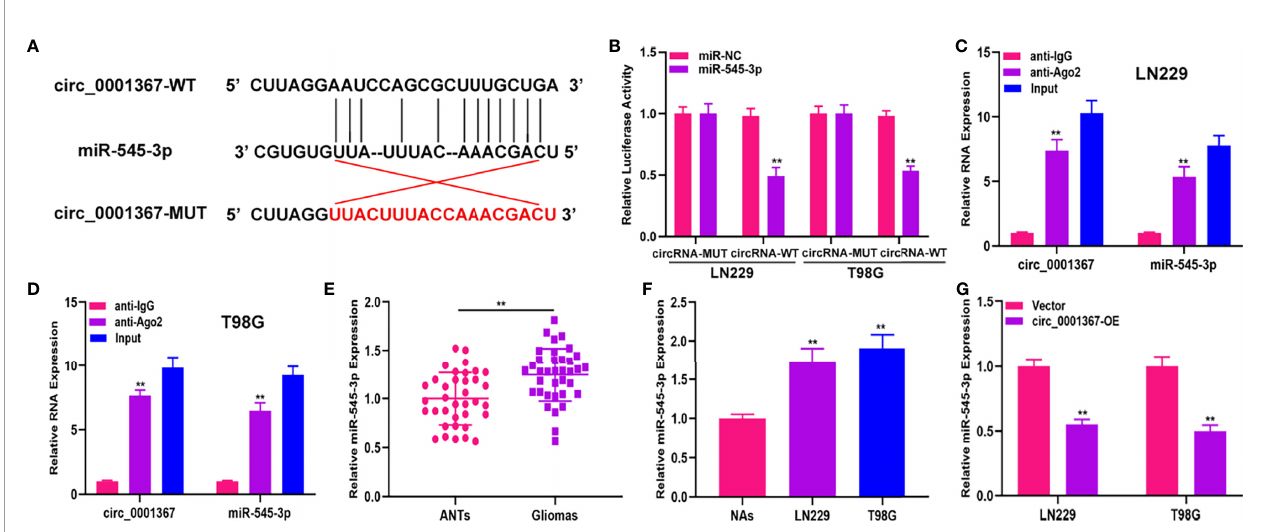
FIGURE 3 | Hsa_circ_0001367 act as a sponge of miR-545-3p. (A) The binding sites between hsa_circ_0001367 and miR-545-3p. (B) Dual-luciferase reporter assay showed that miR-545-3p could more greatly decrease the luciferase activity of circ_0001367-WT than circ_0001367-MUT. (C, D) RIP assay was performed to verify the relationship between circ_0001367 and miR-545-3p. (E) qRT-PCR was used to detect the expression of miR-545-3p in clinical samples. (F) qRT-PCR was used to detect the expression of miR-545-3p in NHAs and glioma cell lines. (G) The expression of miR-545-3p in T98G and LN229 cells transfected with circ_0001367 plasmid was detected by qRT-PCR. **P <